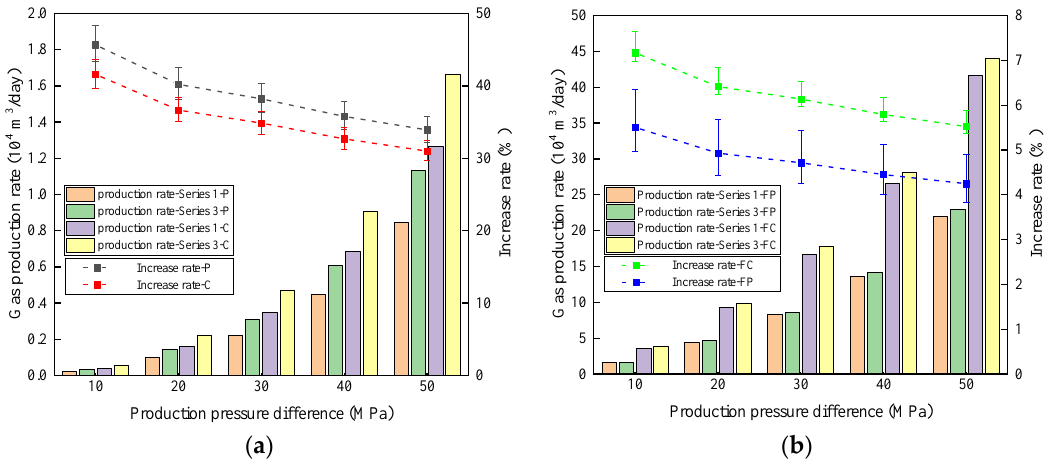
Figure 12. Influence of SB on gas production rate: ( a ) reservoirs without fractures; ( b ) reservoirs with fractures.